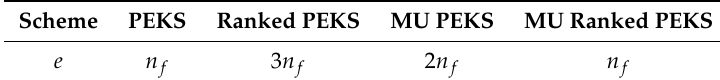
Table 3. The efficiency of test phase.